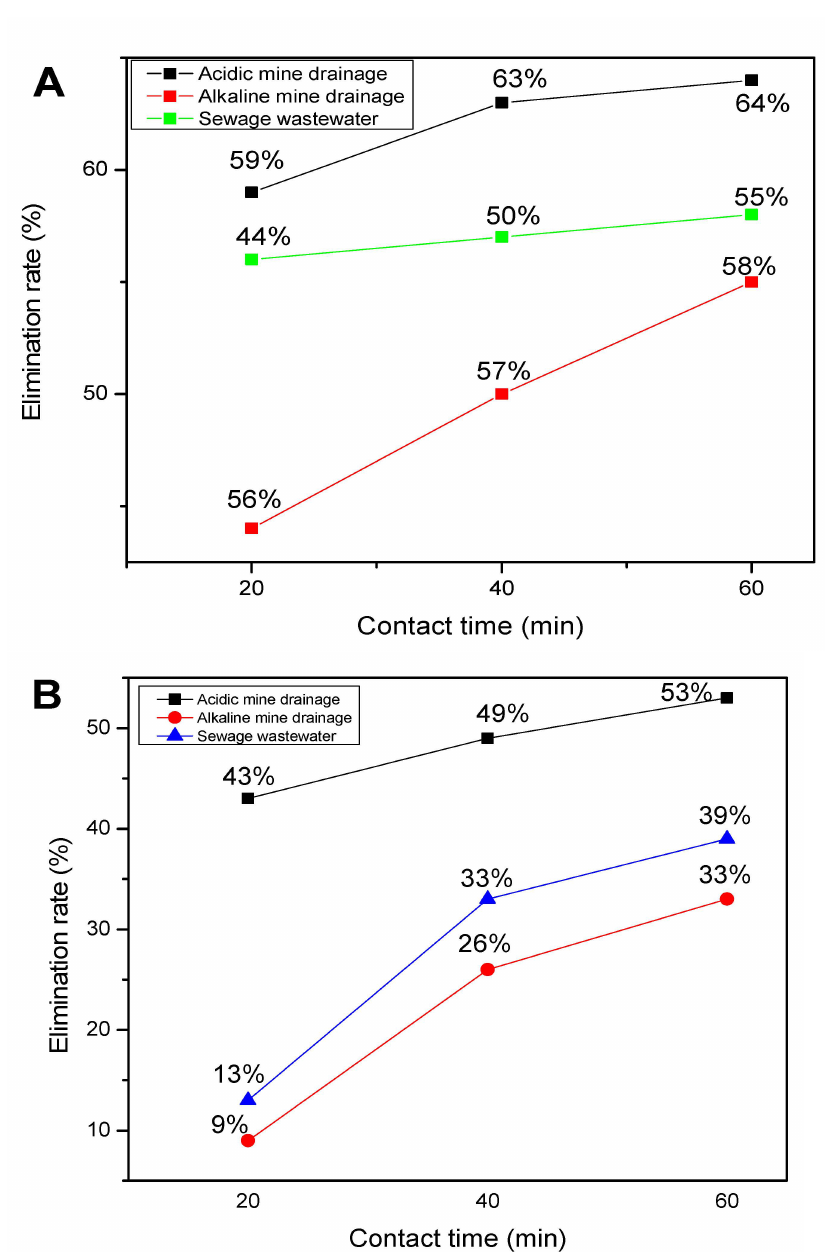
Figure 4. PhotodegradationofPAHswith( A )aflat-bedphotoreactorand( B